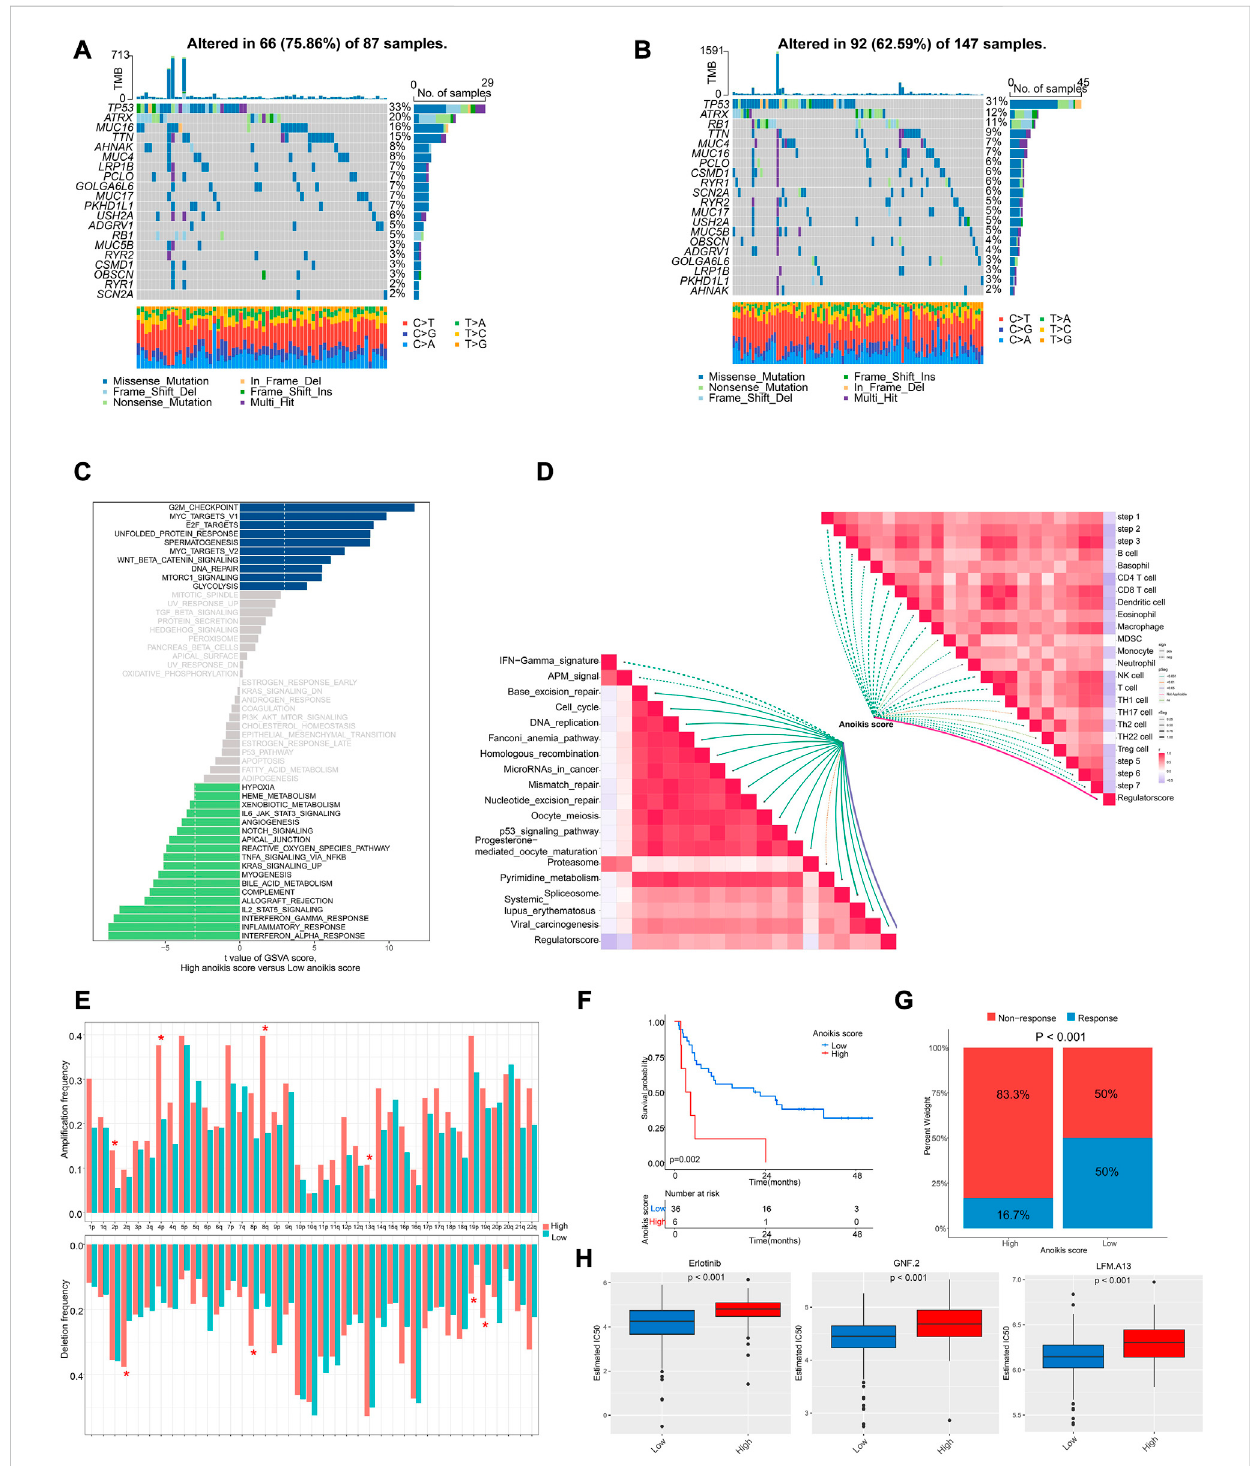
FIGURE 7 The genomic and transcriptional characteristics between Anoikis score groups. (A, B) The differences in mutation frequency between high (A) and low (B) Anoikis score groups. (C) The GSVA illustrating signi fi cantly differently enriched pathways between Anoikis score groups. (D) The correlation analysisofAnoikisscorewithimmunotherapy-predictedpathwaysandcancerimmunitycycles. (E) Thefrequencyofarm-levelampli fi cationanddeletion betweenAnoikisscoregroups. (F) TheKaplan-MeiercurvecomparingthesurvivalbetweenlowandhighAnoikisscoregroupsinanimmunotherapy cohort. (G) TheratesofclinicalresponsebetweenAnoikisscoregroupsinanimmunotherapycohort. (H) Theboxplotsshowingsigni fi cantdifferencesin the estimated IC50 of several drugs between Anoikis score groups in TCGA-SARC cohort. *, p <